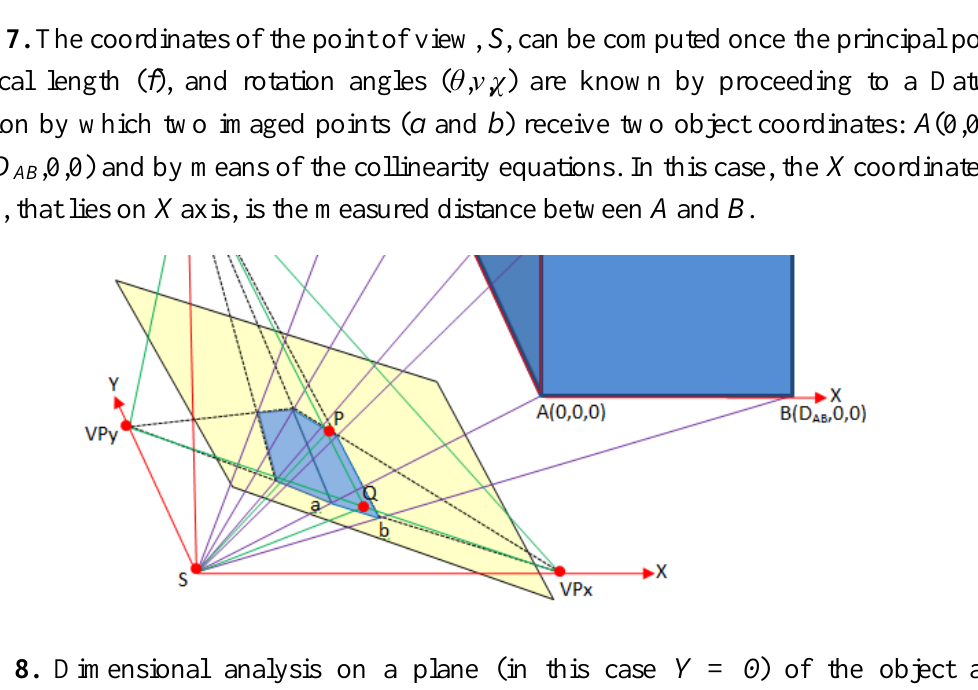
= 0, by means of the T